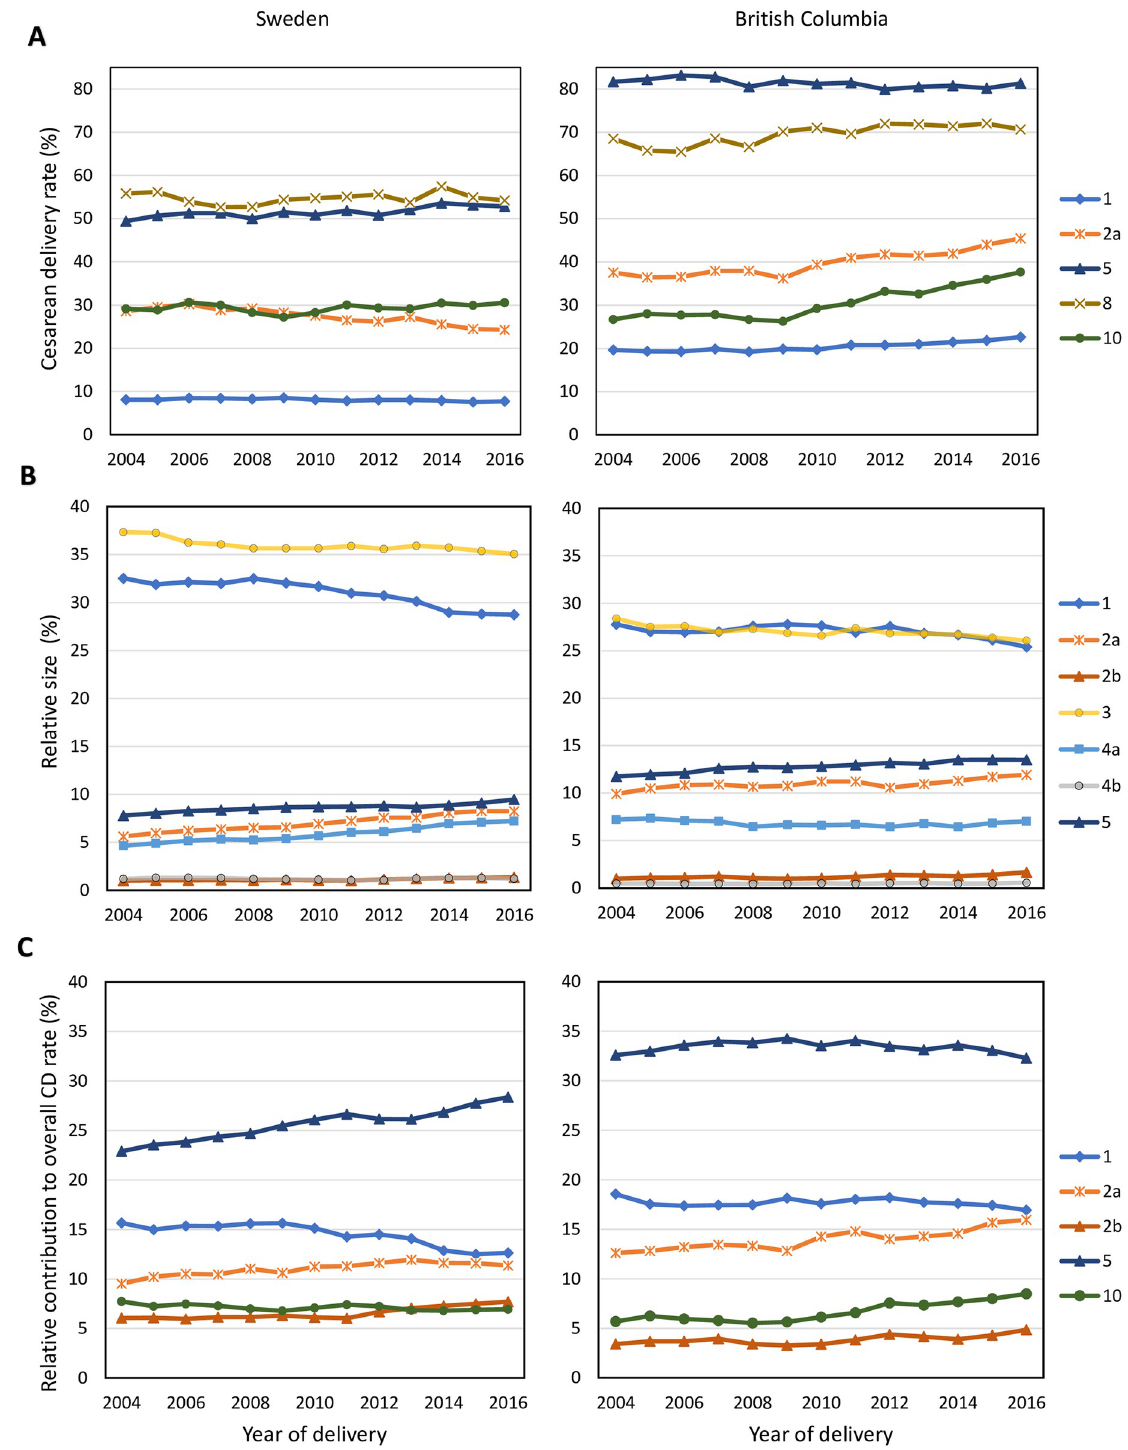
Fig 2. Rate of CD (panel A), relative size (panel B), and contribution to the overall CD rate (panel C) among selected Robson groups, Sweden, and BC, Canada, 2004–2016. BC, British Columbia; CD, cesarean delivery.